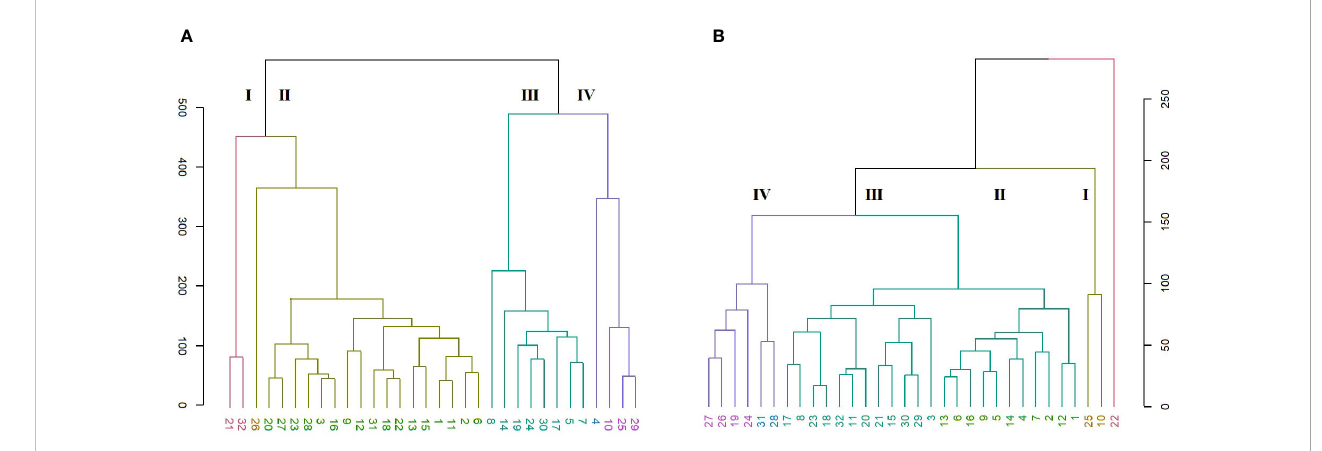
FIGURE 3 HCA of color characteristics of Cyclamen genotypes fl owers (A; r =0.92) and leaves (B; r